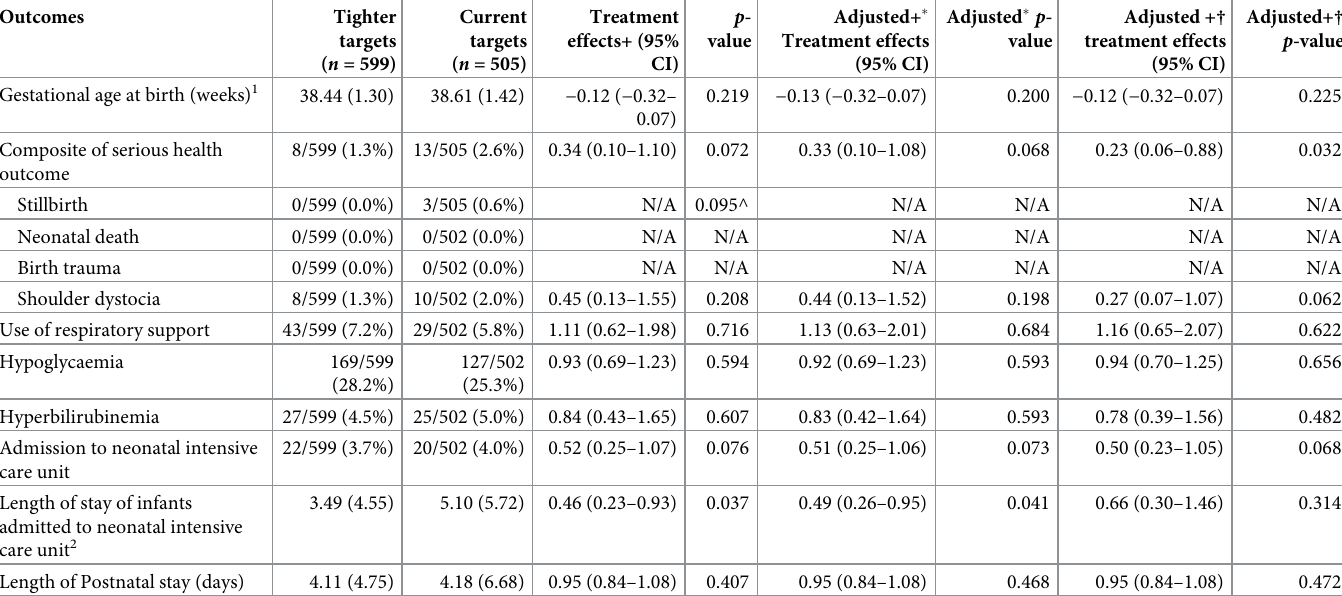
Table 3. Other secondary infant